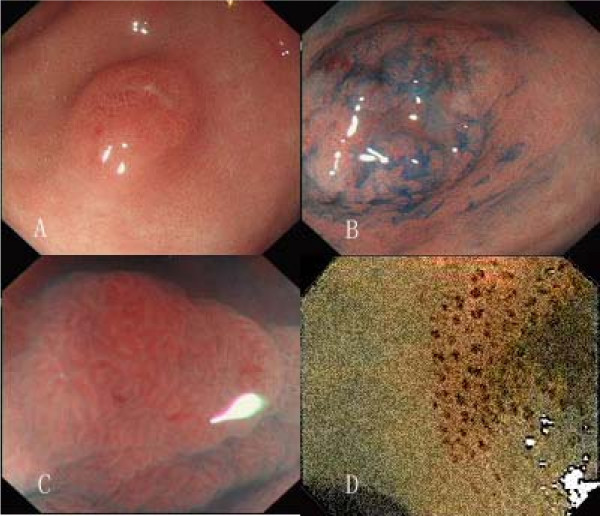
Demonstration of gastric precancerous lesion with conventional endoscopy(A) and iodine staining pattern (B); Pit pattern of this precancerous lesion with magnifying chromoendoscopy (C) and Blood capillary form with magnifying NBI (D).